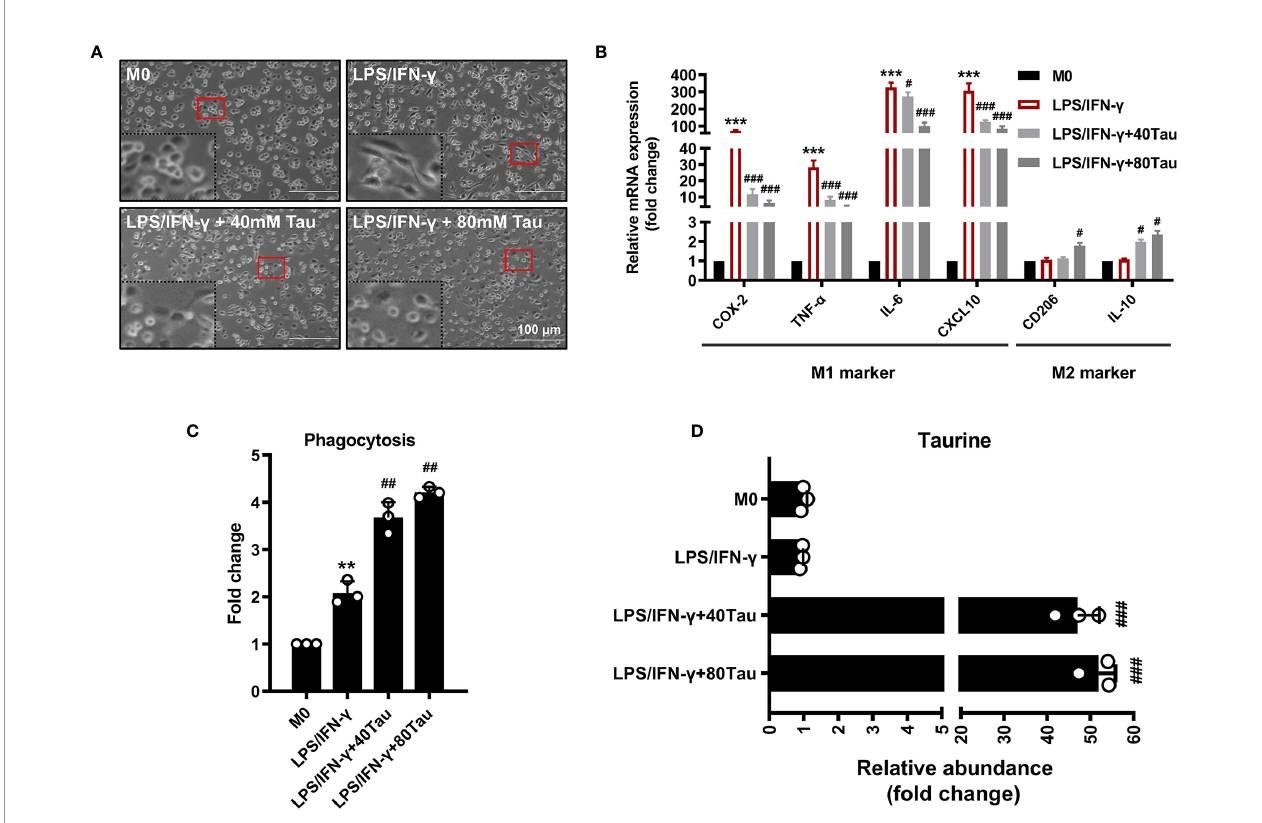
FIGURE 2 | Taurine supplementation attenuates macrophages M1 polarization. (A) The effect of taurine on morphology of M1 macrophages polarization. (B) M1 and M2 marker mRNA levels in M1 polarization with taurine treatment. (C) Effect of taurine on phagocytosis of macrophage. (D) Taurine abundance in M1 macrophage polarization after exogenous taurine intervention. n=3. **p < 0.01, ***p < 0.001 vs. M0; #p < 0.05, ##p < 0.01 and ###p < 0.001 vs. LPS/IFN- g